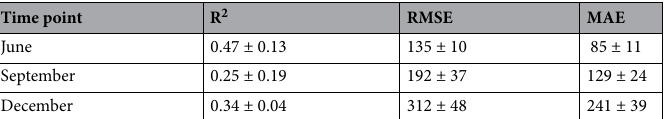
Table 4. Performance measures of the RF regression model at each selected time point, using the selected Boruta features and averaged over 5 runs of cross validation (with the respective standard deviations).